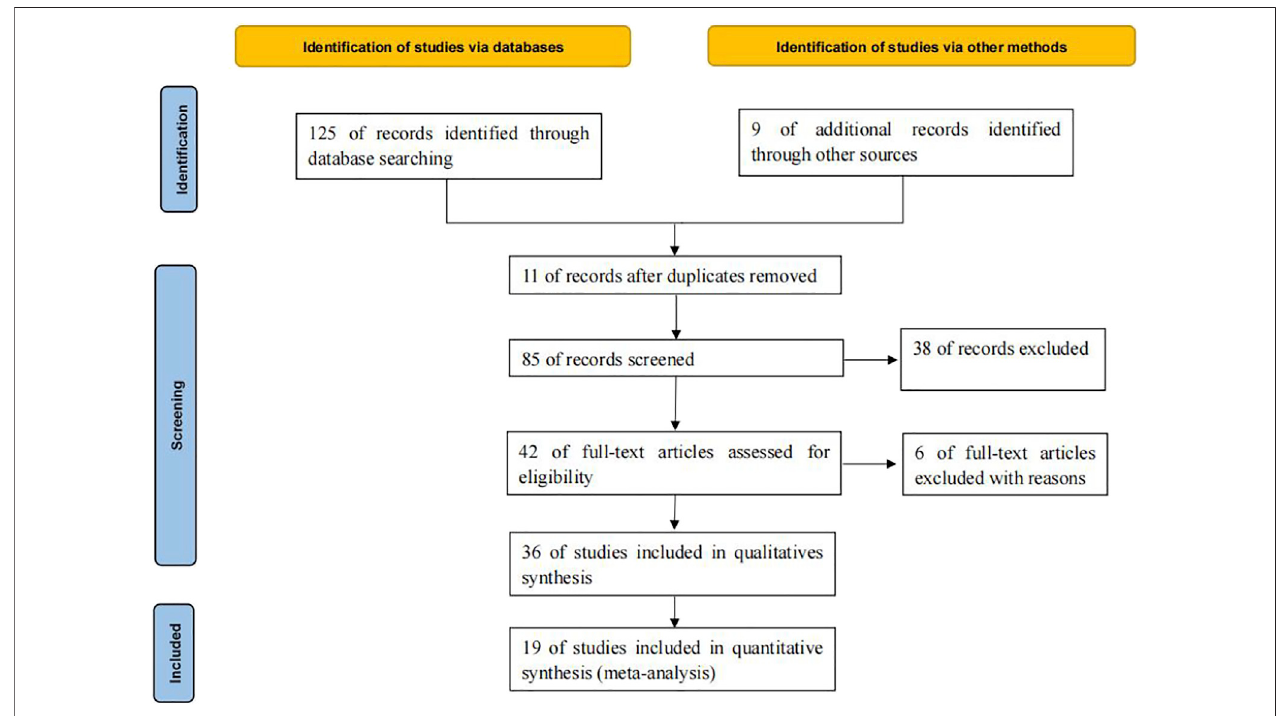
FIGURE 1 | PRISMA Flow chart of article selection.